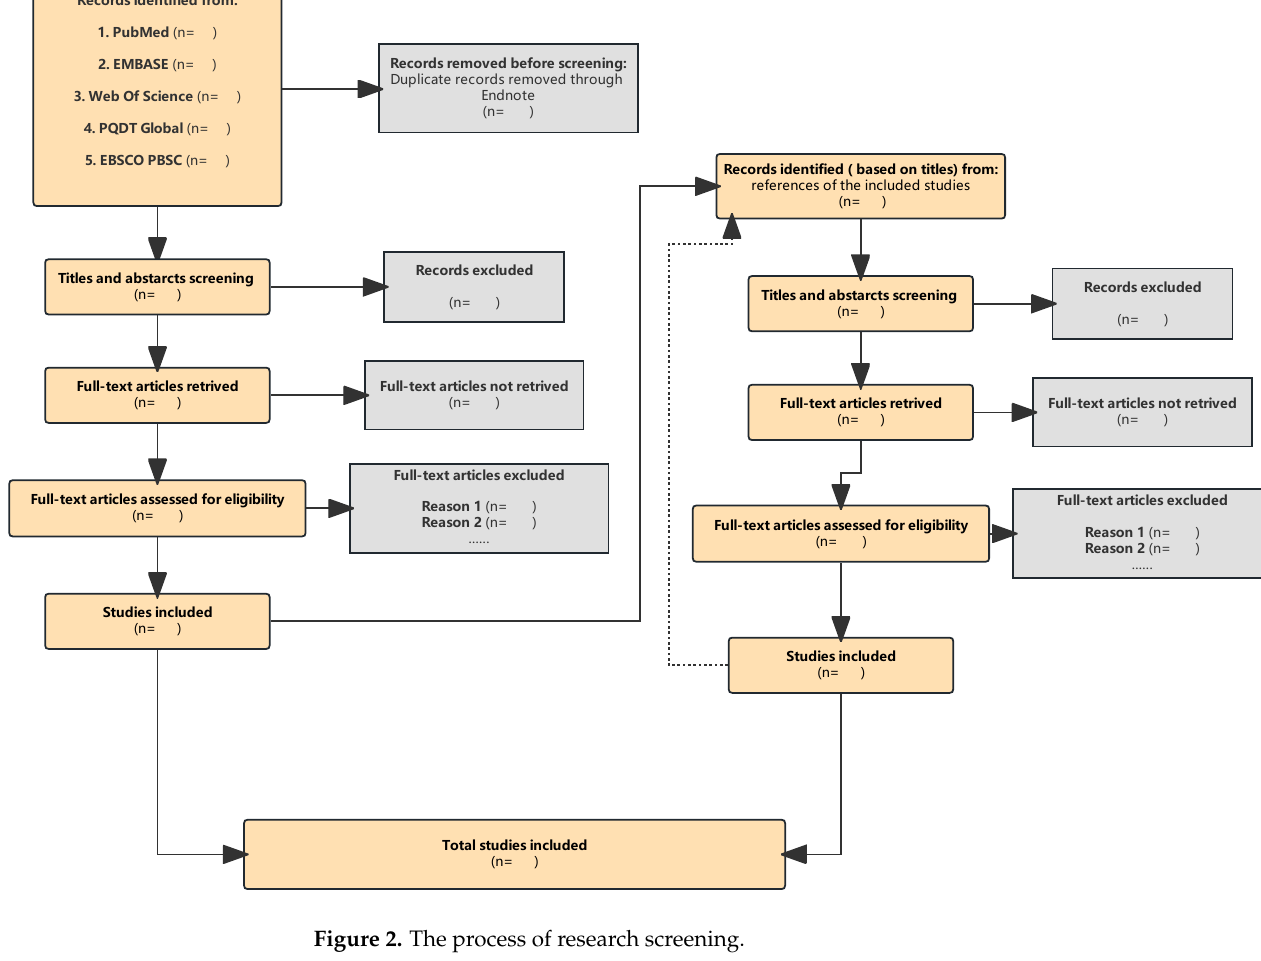
Figure 2. The process of research screening.